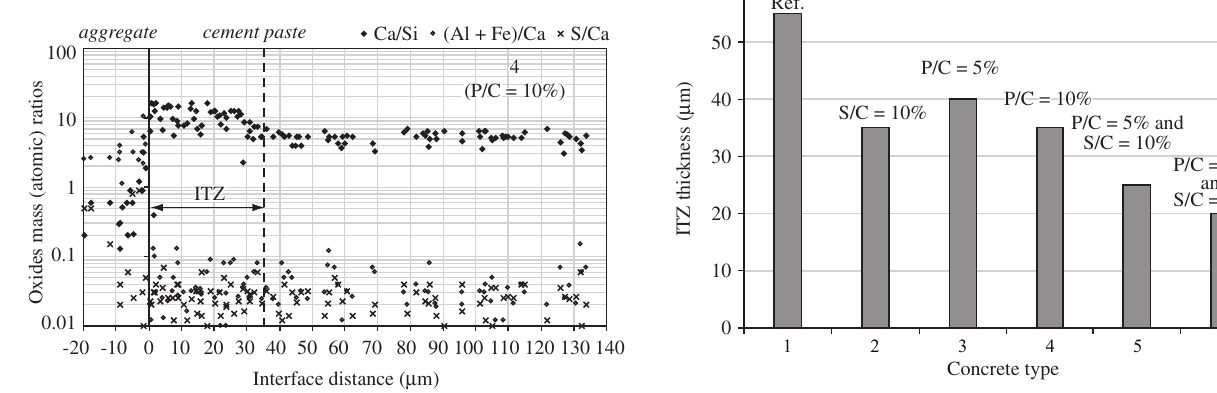
Figure 5. The ratios of Ca/Si, (Al + Fe)/Ca and S/Ca to concrete 4 (P/C = 10%).